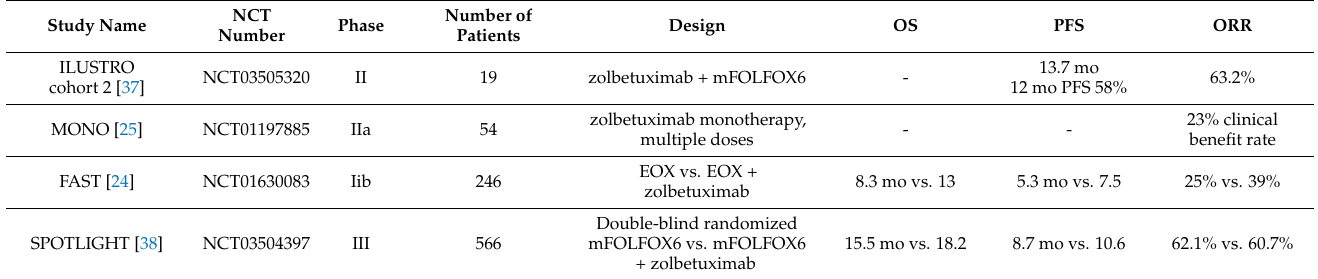
Table 1. Phase II and III clinical trials with the anti-CLDN18.2 monoclonal antibody zolbetuximab in